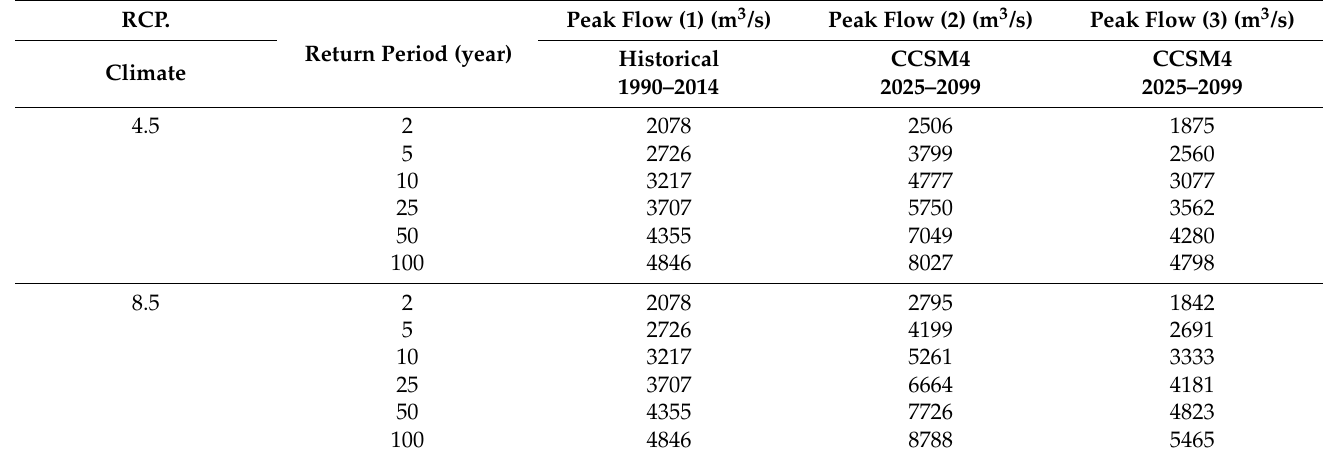
Table 2. Peak flows for the current and future climate and dam scenarios. RCP.